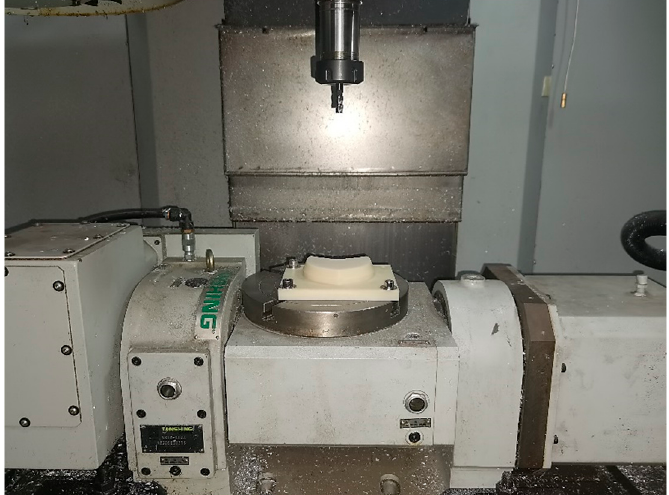
Figure 10. The machining process of the cardioid curve interpolation.